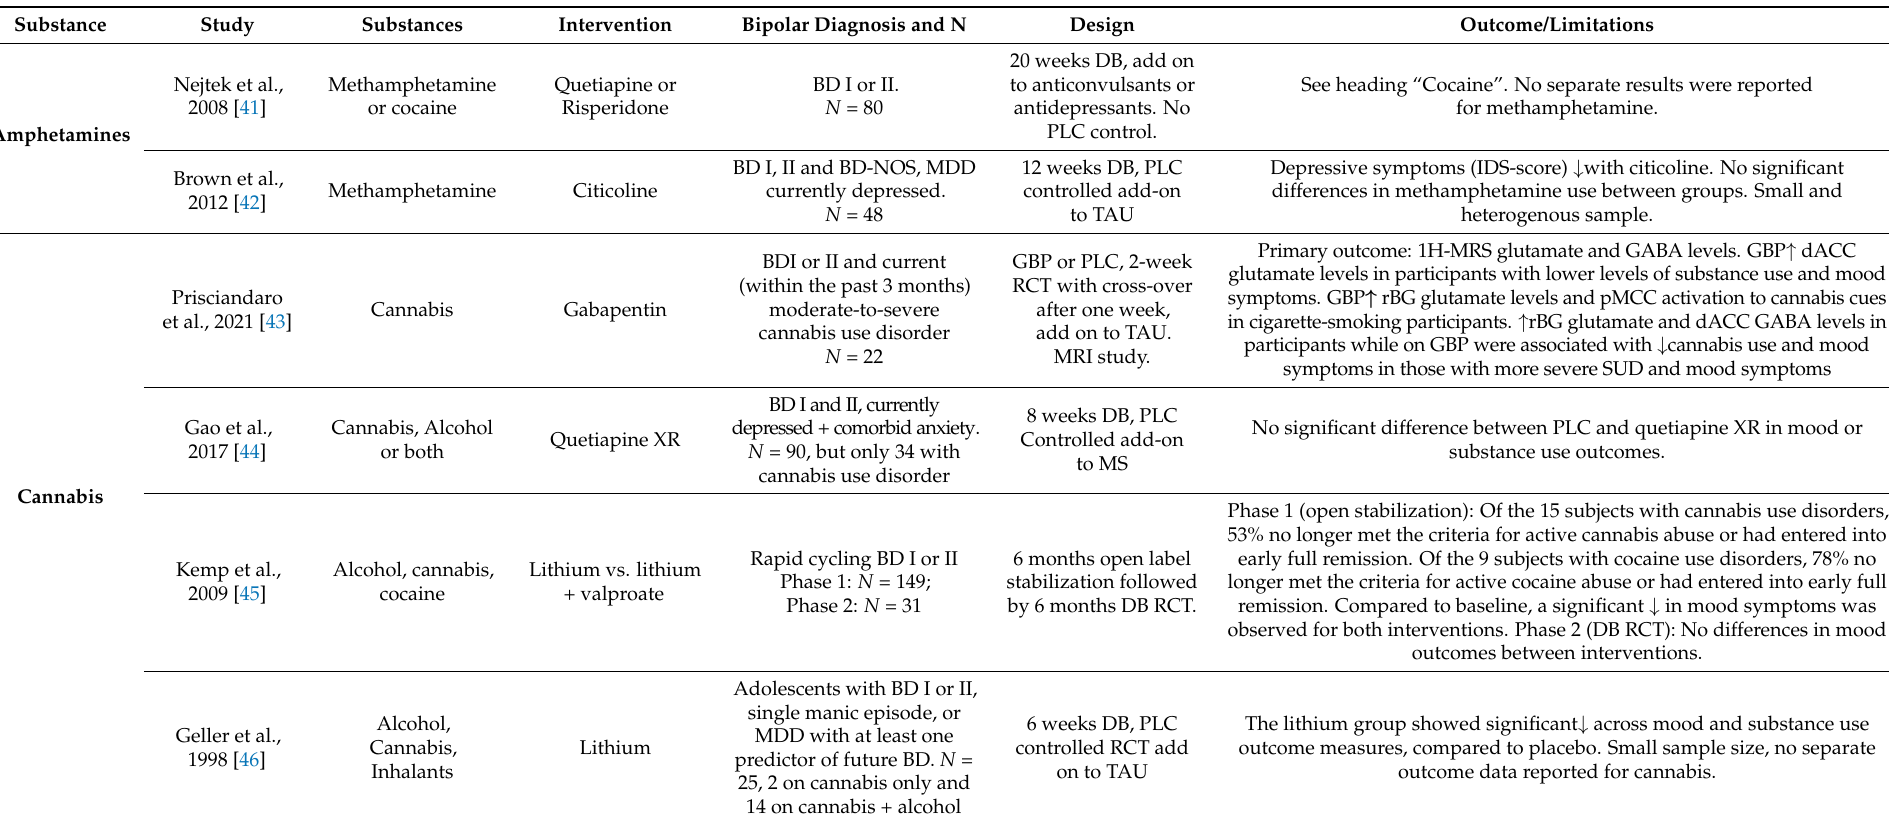
Table 2. Randomized, controlled pharmacotherapy studies in BD comorbid with SUD (other than AUD or tobacco use